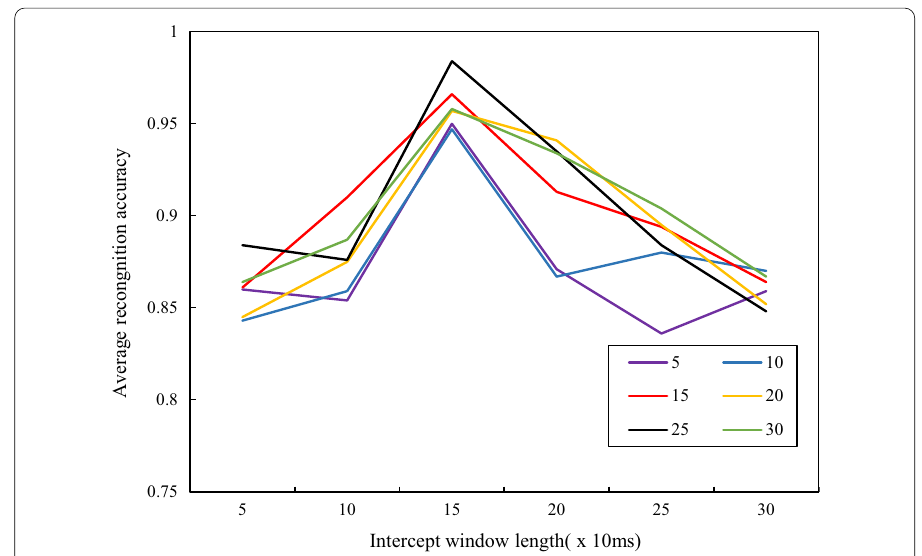
Fig. 10 The influence of window length and the number of features selected on the recognition